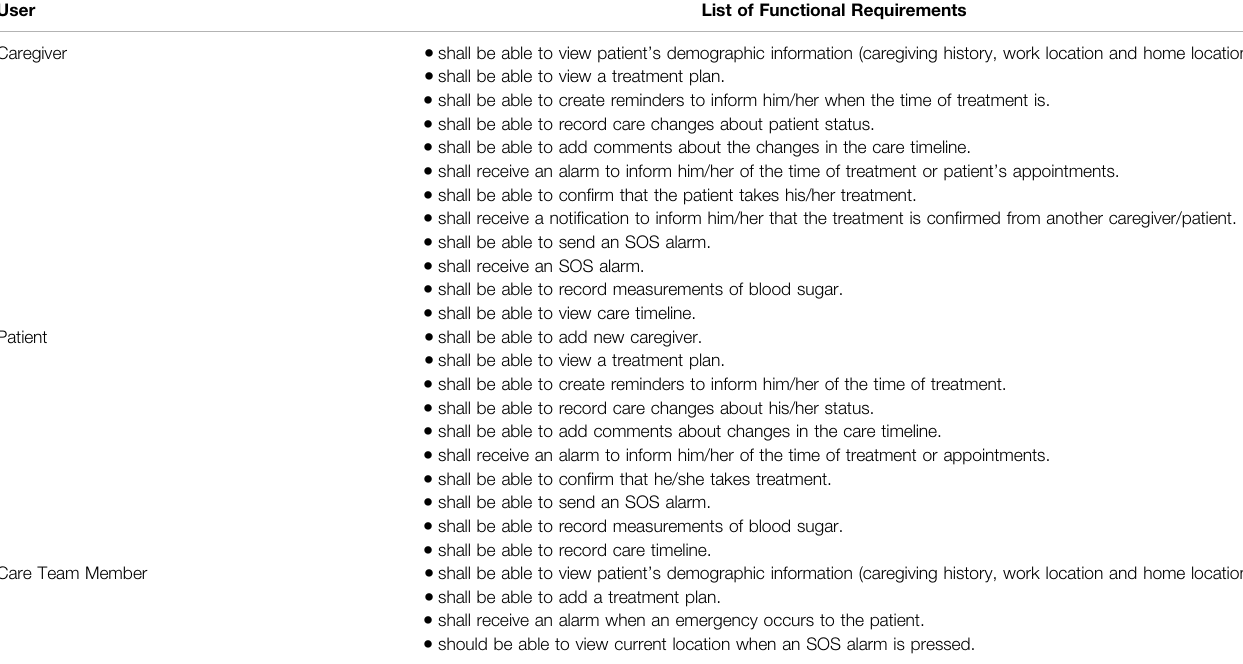
TABLE 1 | eHomeCaregiving Functional Requirements User List of Functional